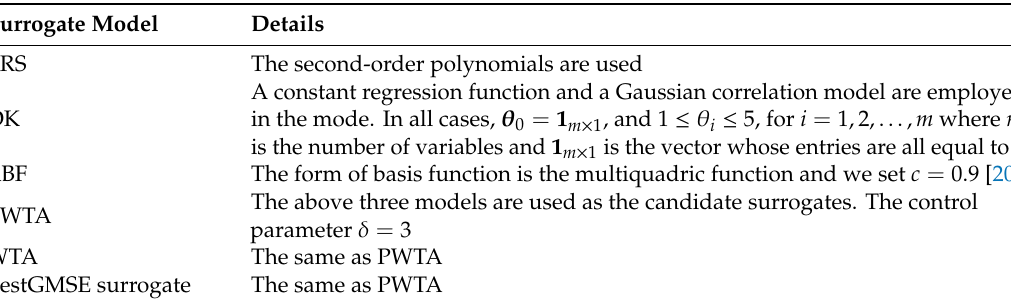
Table 1. Parameters for di ff erent surrogate models.